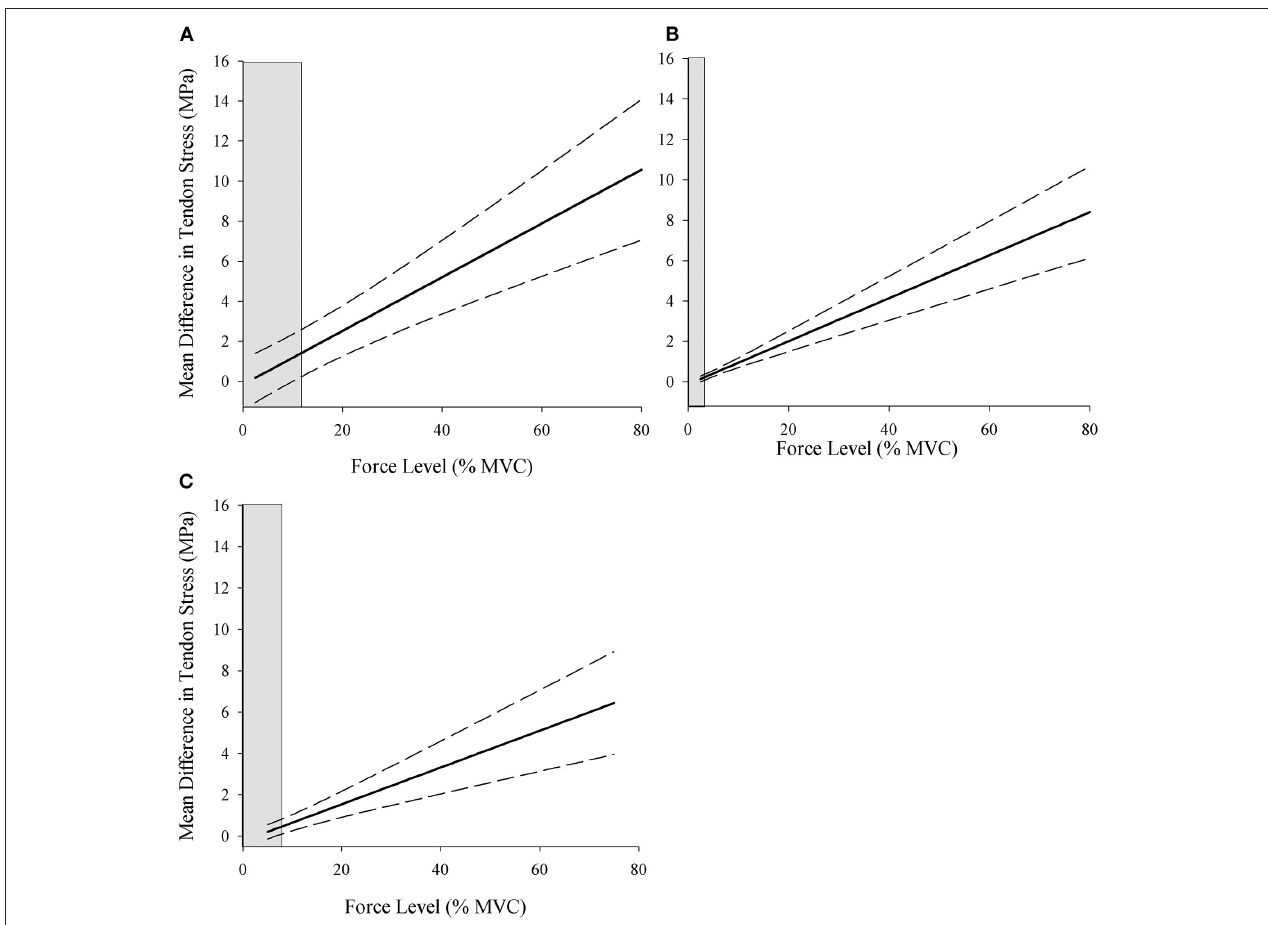
FIGURE 3 | Johnson–Neyman regions of significance for the difference in stress calculated using the resting and instantaneous CSA for young males (A) , old males (B) , and young females (C) . Values to the right of the shaded areas indicate the statistically significant differences between stress values calculated using the resting and instantaneous tendon CSA ( p < 0.05). MVC, maximal voluntary contraction; MPa, megapascals.